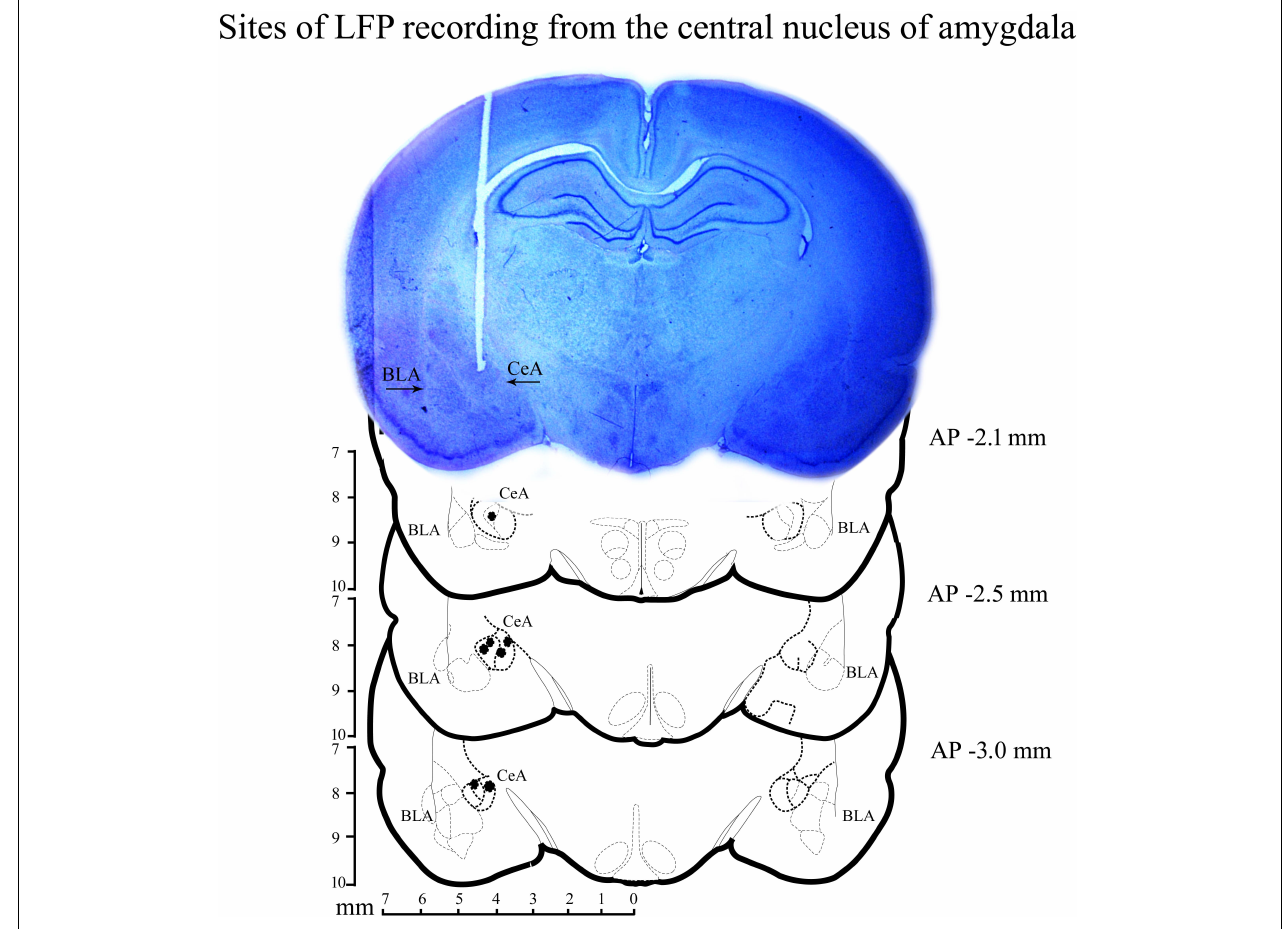
FIGURE 2 | A histological microphotograph of 40- µ m cresyl violet stained coronal section of the rat brain and reconstruction diagram showing the sites of local field-potential (LFP) recording from the central nucleus of amygdala. Filled circles ( • ) denote the sites of